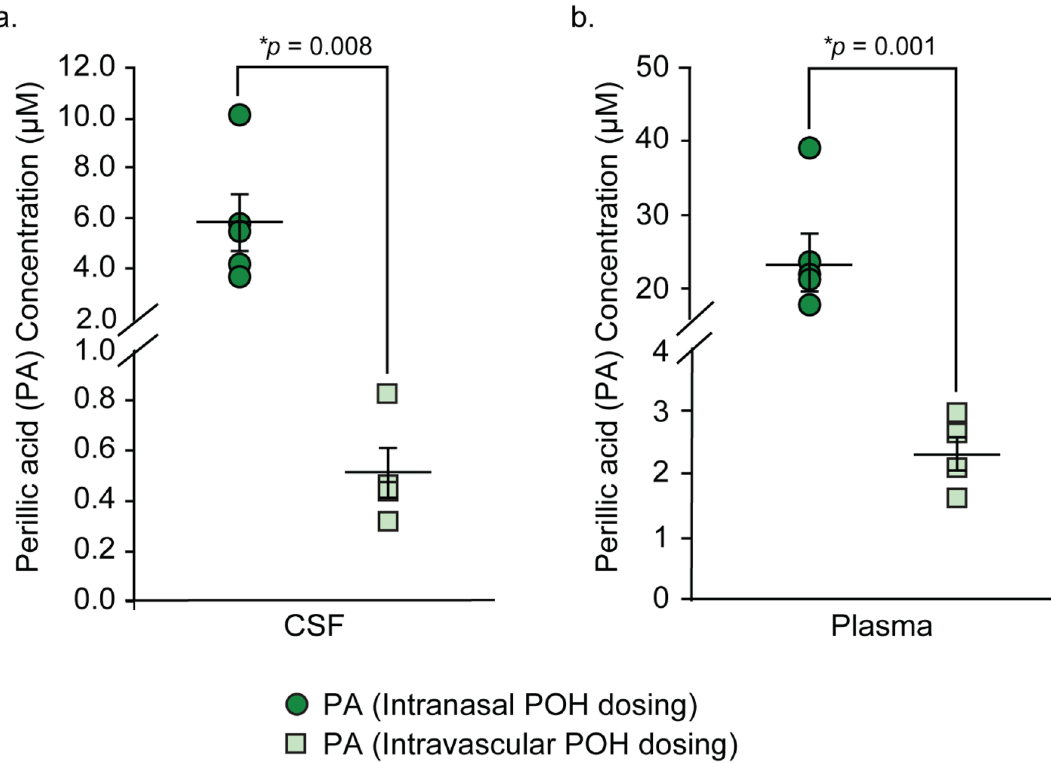
Figure 3. Average PA concentration in the CSF and plasma following equal-dose intranasal and intravascular POH administration. (a) Concentration of PA in the rat CSF following intranasal (dark green circles) and intravascular (light green squares) POH administration. (b) Concentration of PA in the rat plasma following intranasal (dark green circles) and intravascular (light green squares) POH administration. * p values calculated by Mann–Whitney rank sum test (a) or Student’s t-test (b) .